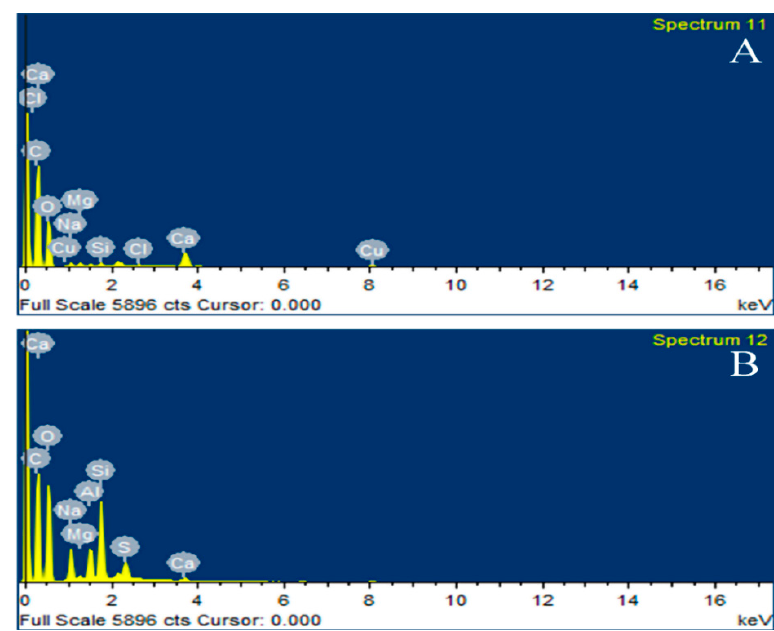
Figure 4. EDX analysis of ( A ) S50P50, ( B ) S50P50D15(3).